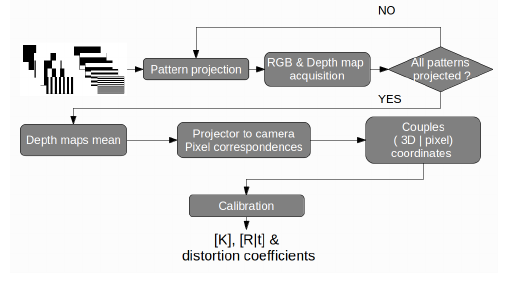
Figure 8. Diagram of the calibration procedure ( image